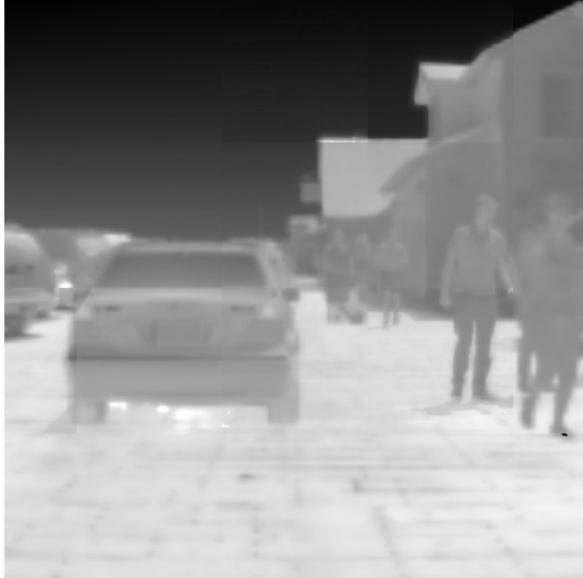
Figure 5. Enhanced thermal image in false color by the BDSD Figure 6. Enhanced thermal image raw band by the BDSD pansharpening algorithm, from the FLIR image